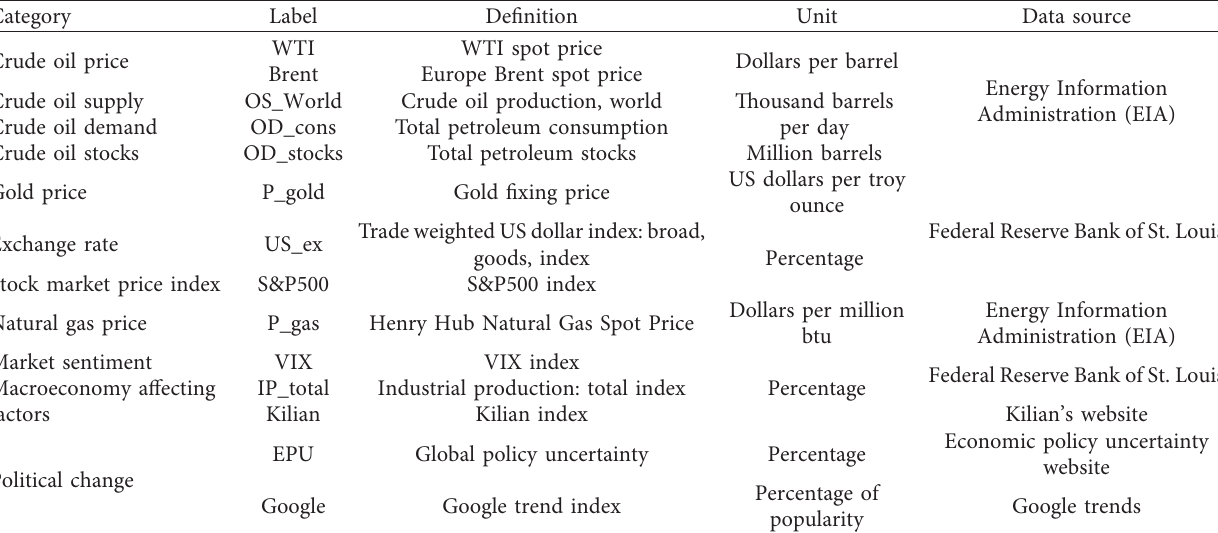
Table 1: Variable